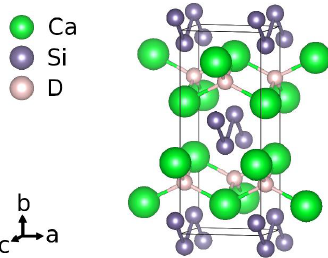
Figure 6. Crystal structure of the deuterium-poor phase CaSiD x . The tetrahedral Ca 4 voids are partially filled. The SOF (D) corresponds to x in the chemical formula. Table 2. Deuterium-poor phases CaSiD x , x = SOF . Labels refer to Figure 7.